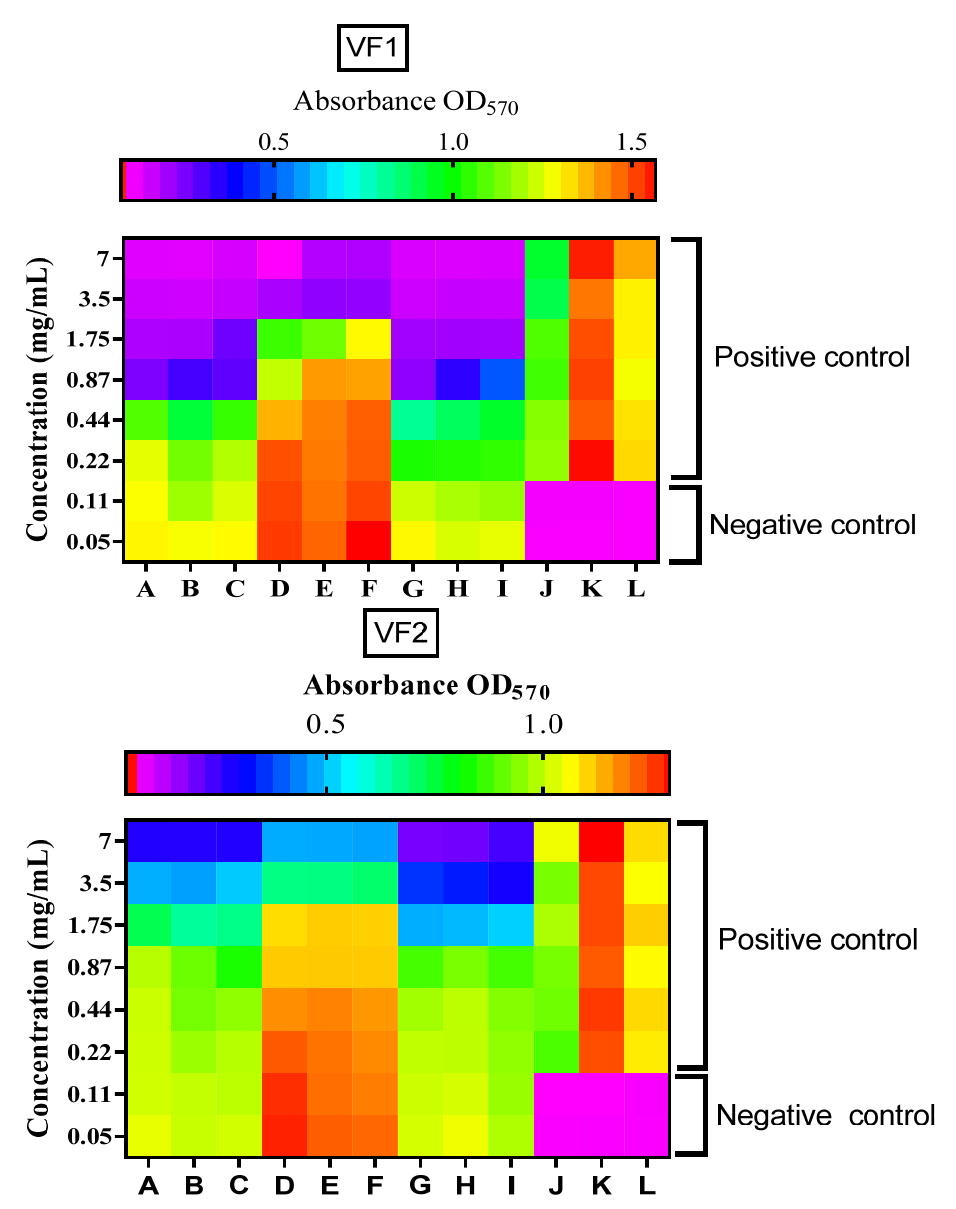
Figure 3. Heatmaps representing spectrophotometric reads (OD) of the microdilution plates at 570 nm using the Multiskan™ FC Microplate Photometer after susceptibility test on Candida spp. to VF1 and VF2 fractions.